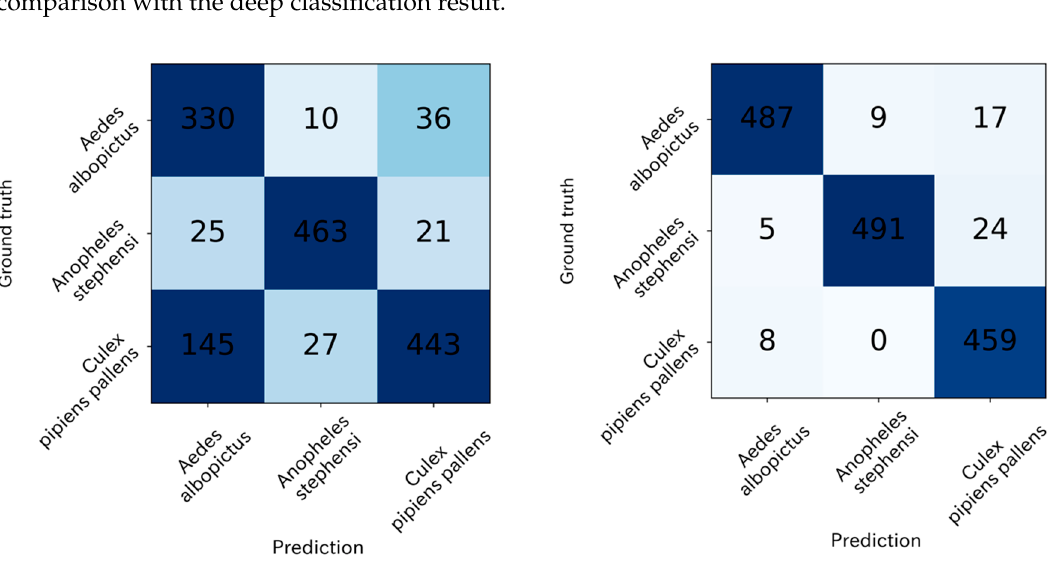
Table 3. Result of deep classification. AlexNet; Visual Geometry Group Network ( VGGNet ); Deep residual network ( ResNet ).